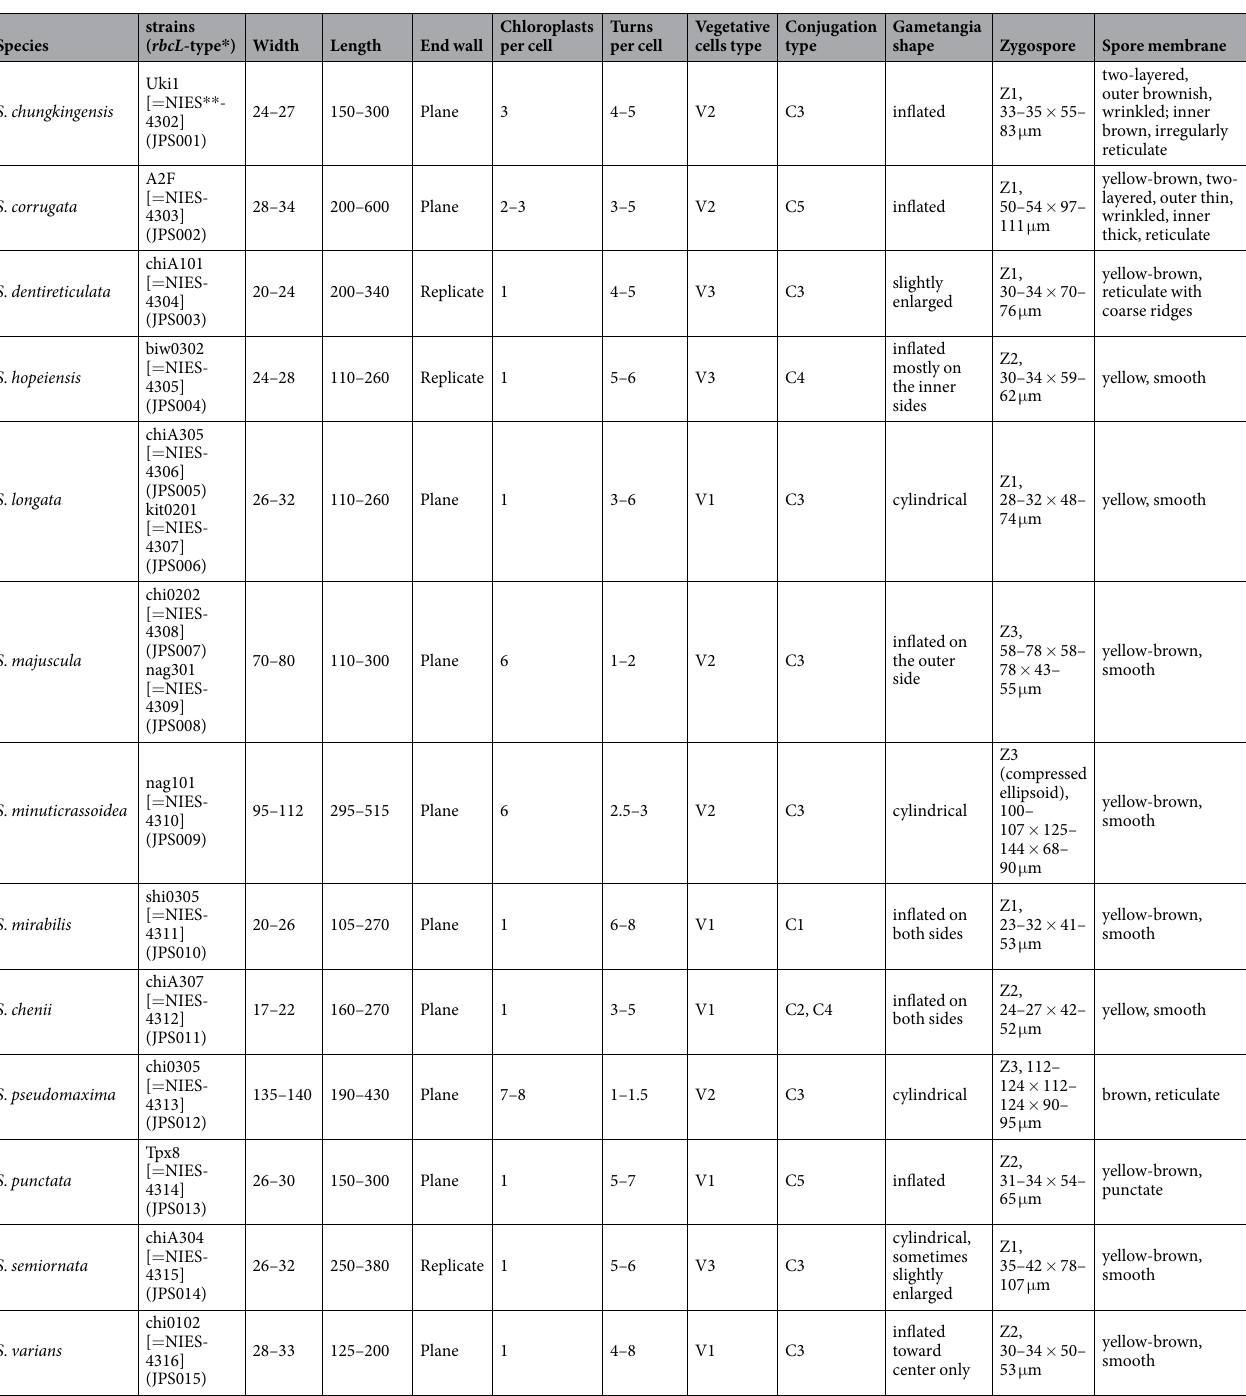
Table 1. Comparison of the morphological characteristics of 13 Spirogyra species in this study. Vegetative cell type, conjugation type and zygospore/aplanospore type are detailed in Supplementary Figs S2–S4. For details of the 13 species, see Supplementary Note S1. * For strain examined in each rbcL -type, see Supplementary Table 1. **